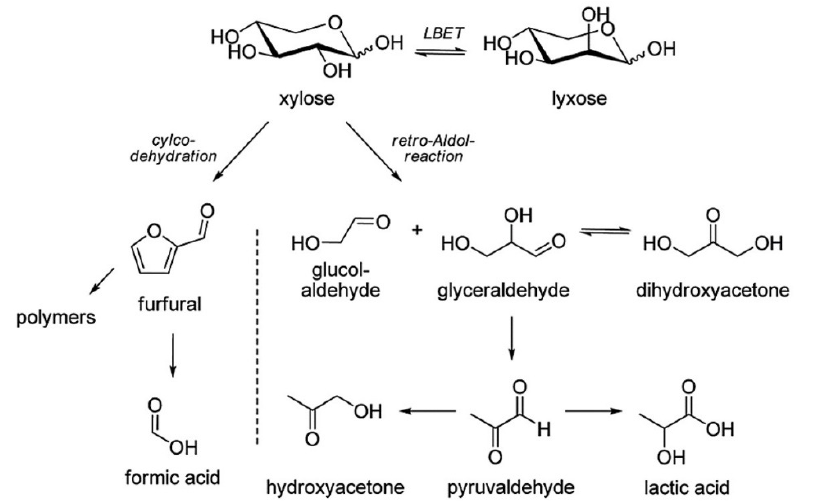
Figure 12. Reaction scheme of xylose degradation and the main degradation products formed. Adapted with permission of the Royal Society of Chemistry from [106]; permission conveyed through Copyright Clearance Center, Inc.